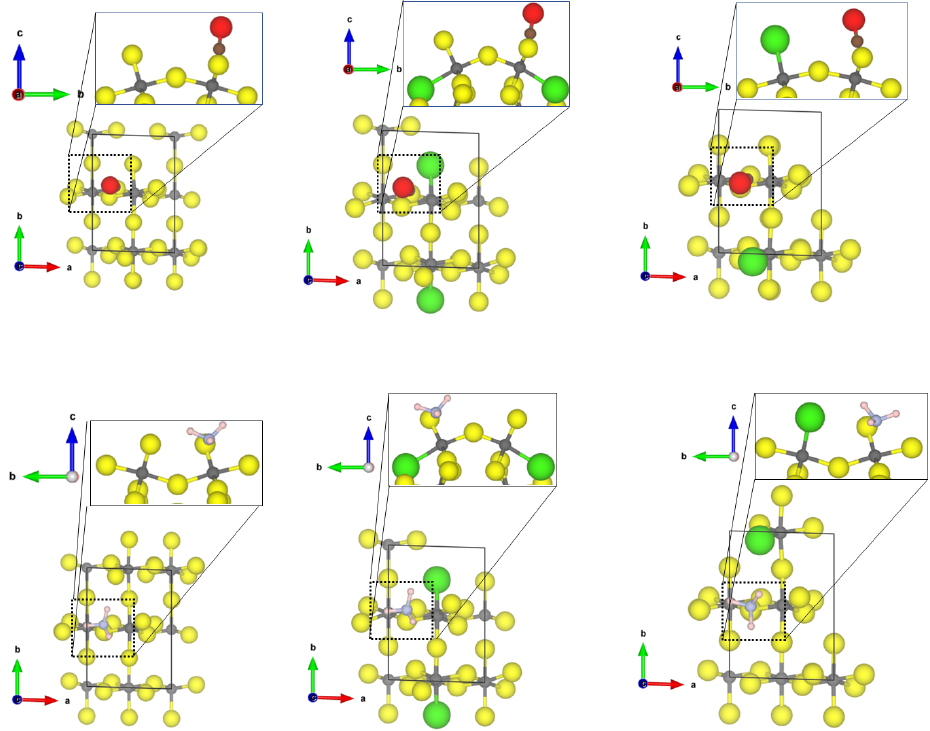
Figure 4. PBE-D3(BJ) optimized structure of the probe molecules CO ( upper row ) and NH 3 ( lower row ) on the α -AlF 3 - ( left ) and Cl-doped α -AlF 3 -(11¯20) ( middle and right ) surfaces; yellow = fluorine, grey = aluminium, brown = carbon, red = oxygen, blue = nitrogen, pink =